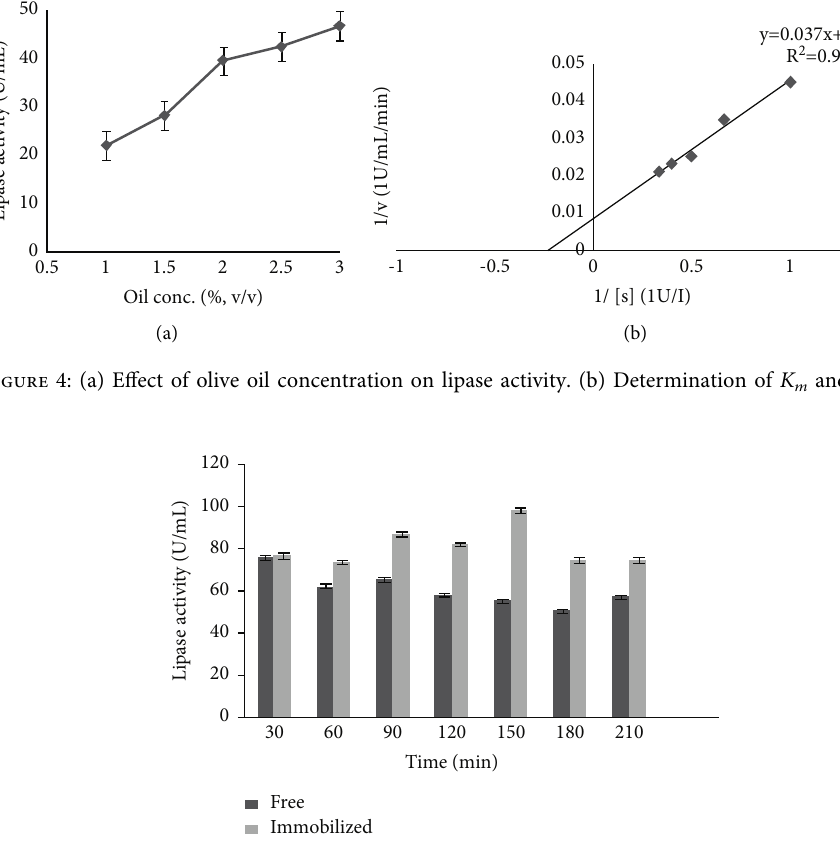
Figure 5: Comparison between free and immobilized lipase activity obtained from K . flava Y4. Table 6: Flow sheet of the K . flava Y4 lipase purification.